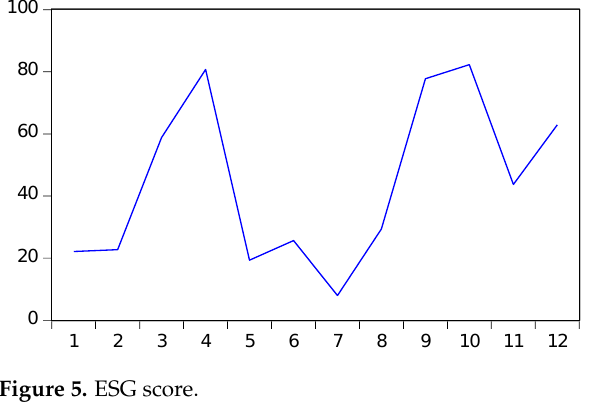
Figure 5. ESG score.